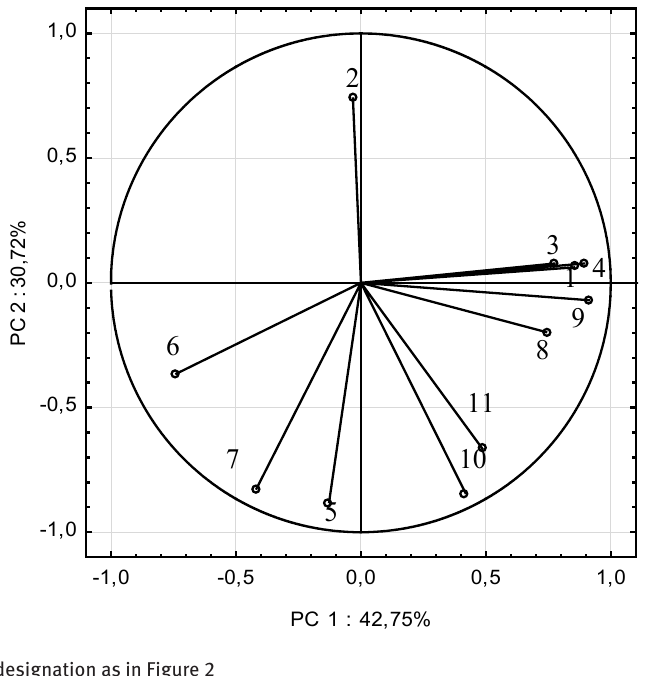
Figure 3 : Dependences observed after inoculation seeds with Rhizobium + Pseudomonas